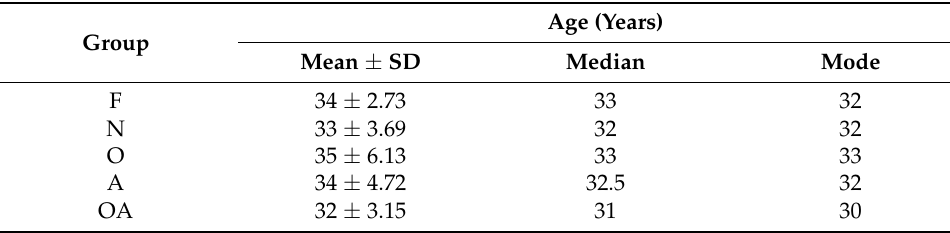
Table 3. Detailed characteristics of patients’